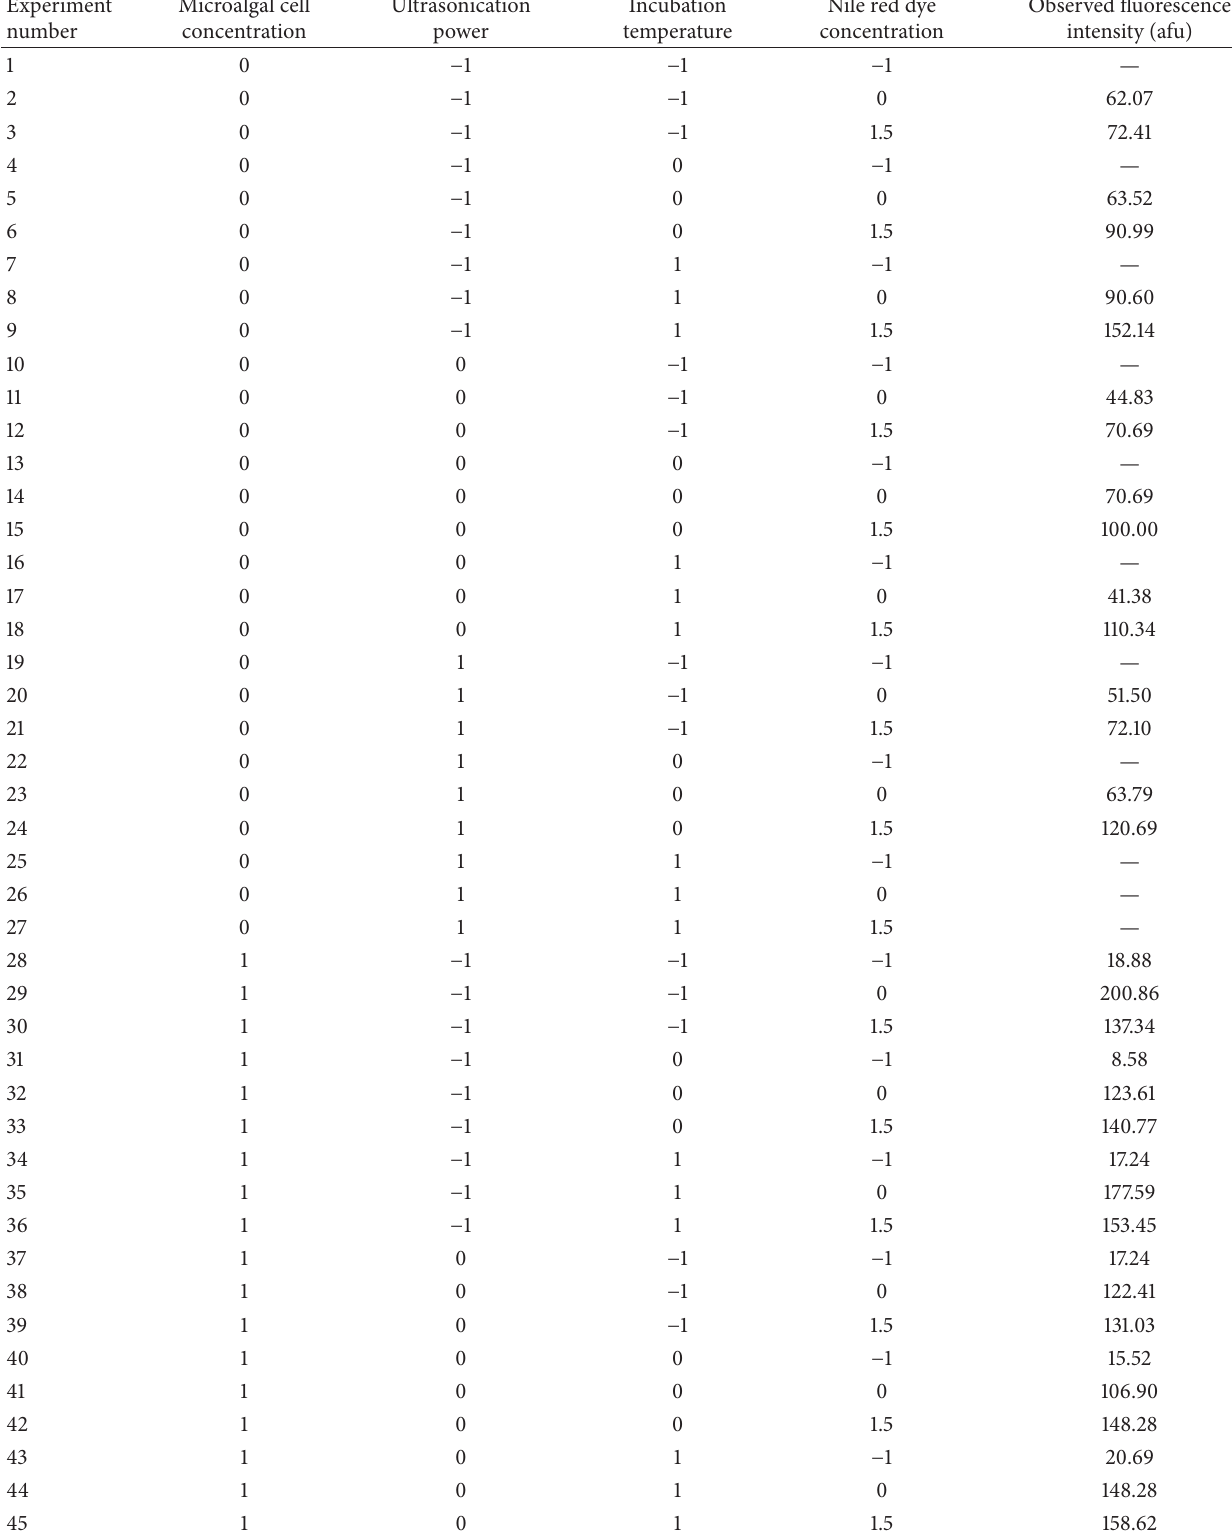
Table 2: Factorial experimental design matrix and values of the observed fluorescence intensity (also referred to as experimental results). Fluorescence intensity was determined at excitation wavelength of 530 nm, emission wavelength of 607 nm, and 15 min poststaining